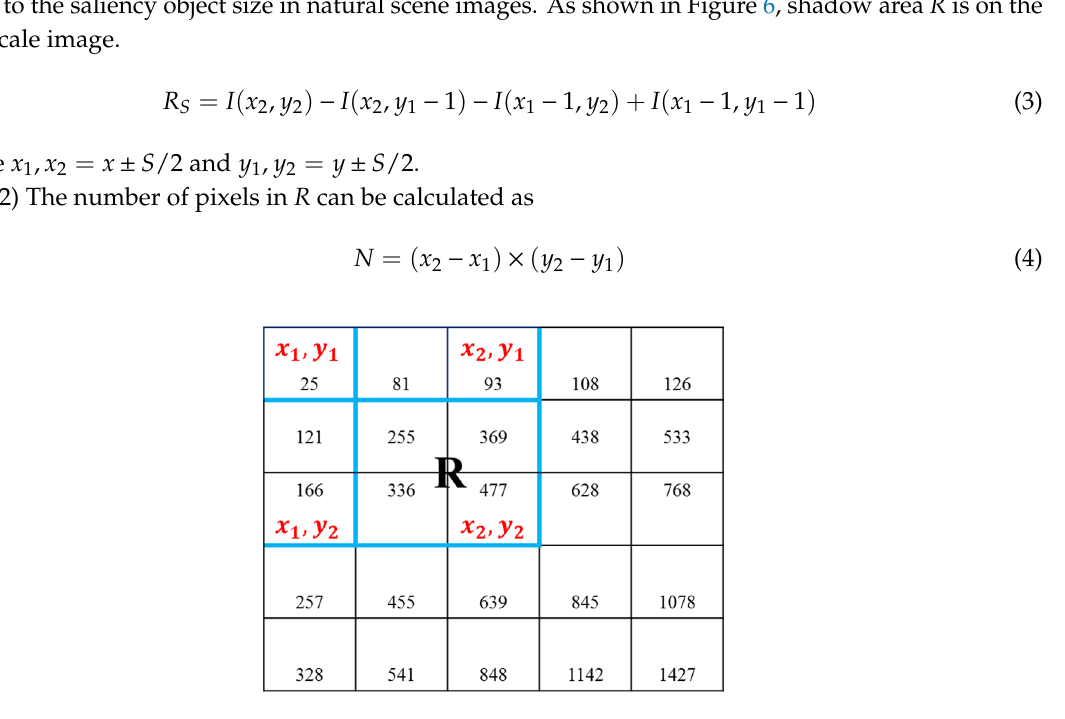
Figure 6. Sum over rectangle R in grayscale image.